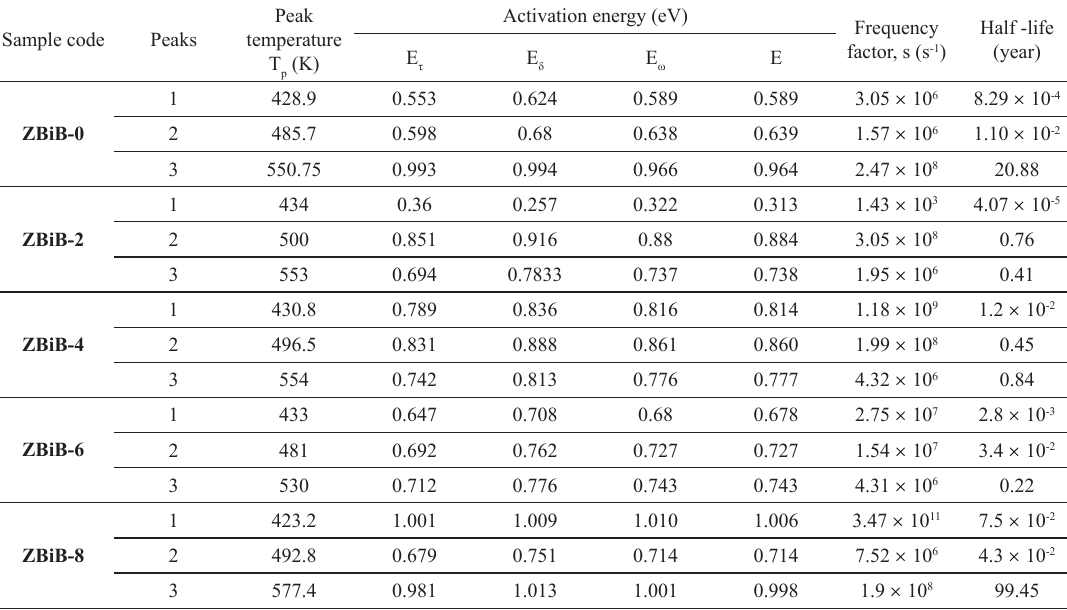
Table 7. TL trap parameters calculated for 5 kGy irradiated ZBiB-0, 2, 4, 6 and ZBiB-8 samples glasses using Chen’s peak shape method. Sample code